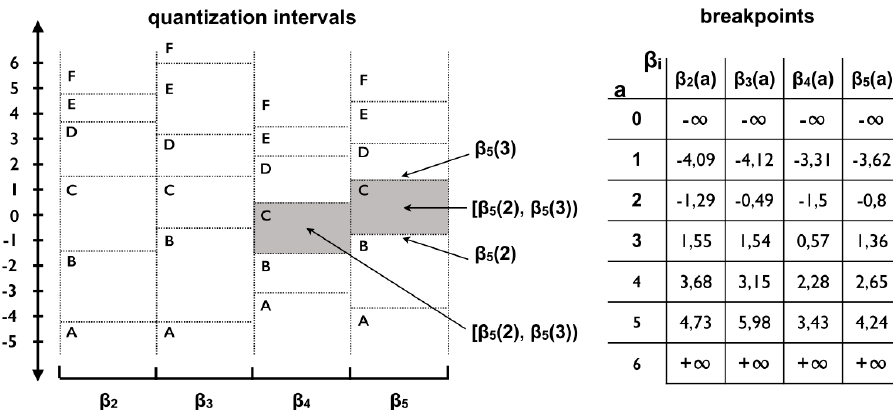
Figure 8. Visual illustration of the distribution of bins and breakpoints in an MCB. In this case, the word size is 4 and the alphabet is 6 [29].